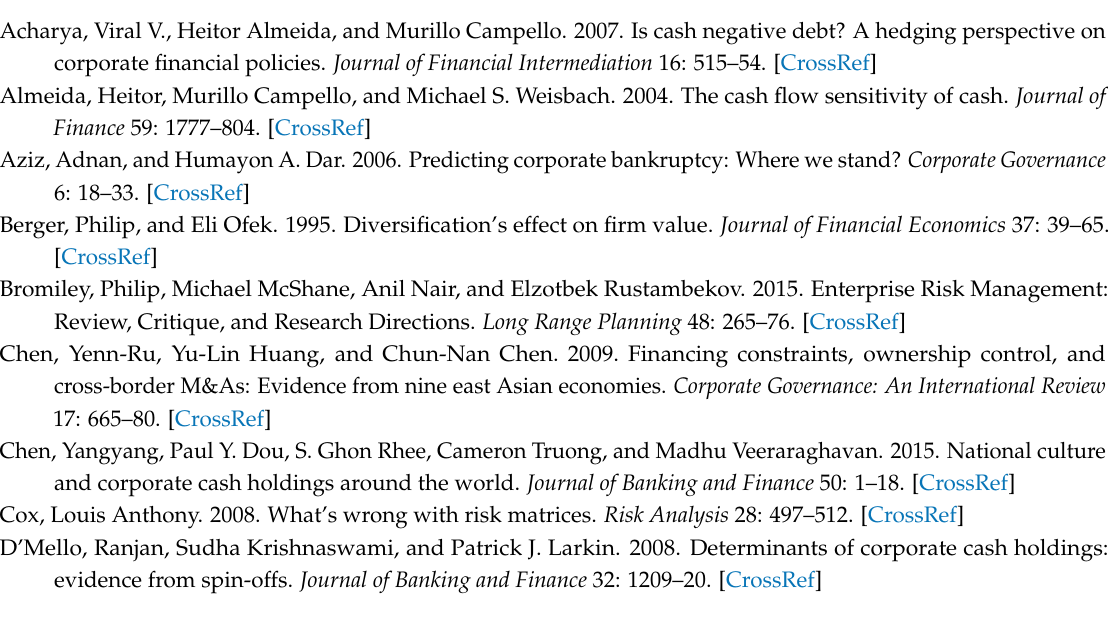
Figure A2. Distribution plots for debt capacity constraint (debt to assets).